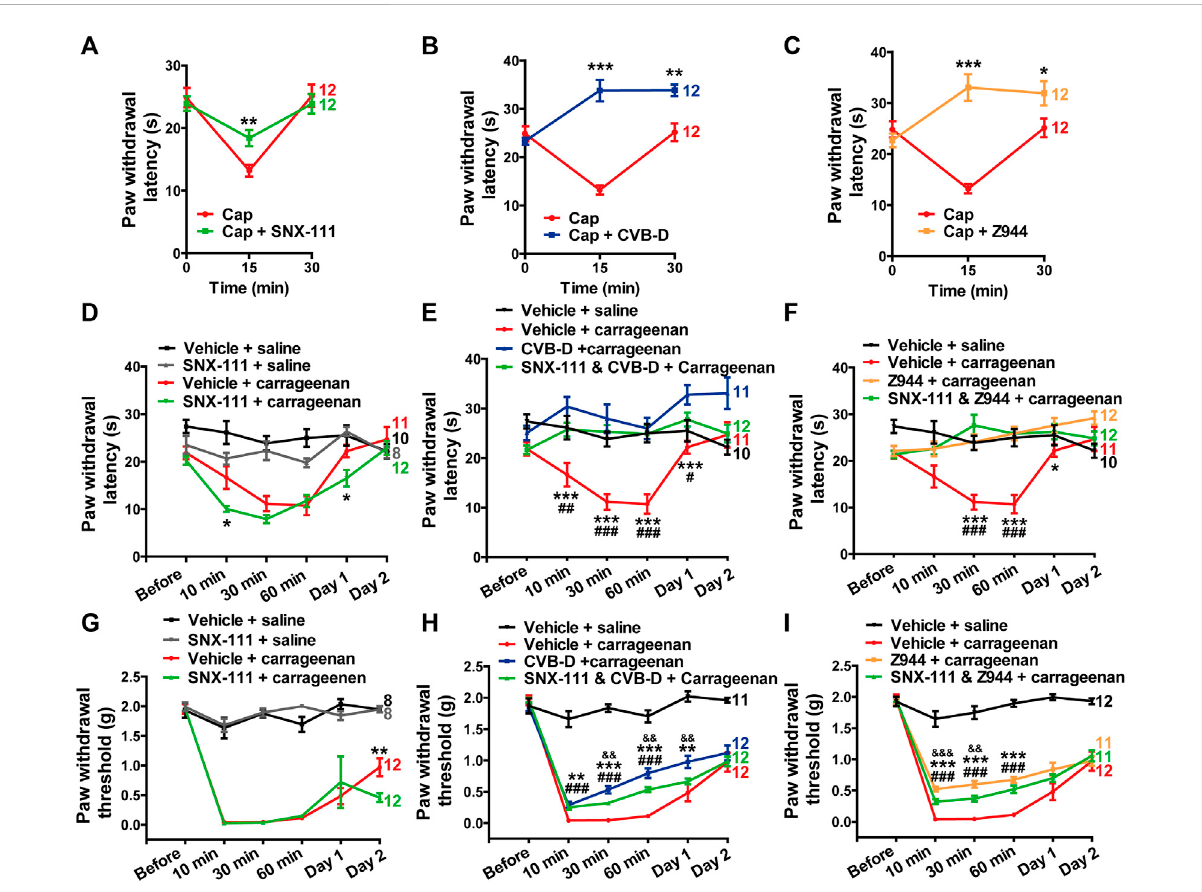
FIGURE 7 MinorroleofCa v 2.2intheanalgesiceffectofCVB-Dinmousemodels. (A – C) EffectofSNX-111(green),CVB-D(blue),orZ944(orange)onCap- induced thermal hypersensitivity. PWL was measured by the hot plate assay at before (0min), and 15 and 30 min after i.pl. injection of Cap. (Red). (D) Effect of SNX-111 on carrageenan-induced thermal hypersensitivity. Same experimental procedures as in Figure 1E, except that SNX-111was intraplantarly injected 30 min prior to carrageenan injection. Statistical analysis was performed between the groups of SNX-111-carrageenan (green)andVehicle-carrageenan(red). (E,F) SynergisticeffectofSNX111andCVB-DorZ944oncarrageenan-inducedthermalhypersensitivity.Same experimental procedures as in D, except that SNX-111 and CVB-D or Z944 were intraplantarly injected together 30 min prior to carrageenan injection. Statistical signi fi cance between the groups of CVB-D-carrageenan (blue) or Z944-carrageenan (orange) and Vehicle-carrageenan (red) wasmarked byasterisks, and that between thegroupsofCVB-D-SNX-111-carrageenan (green)orZ944-SNX-111-carrageenan (green)and Vehicle- carrageenan (red) was marked by pound signs. (G) Effect of SNX-111 on carrageenan-induced mechanical hypersensitivity. Same experimental proceduresasinFigure1E,exceptthatSNX-111wasintraplantarlyinjected30 minpriortocarrageenaninjection.Statisticalsigni fi cancebetweenthe groups of SNX-111-carrageenan (green) and Vehicle-carrageenan (red) was marked by asterisks. (H) Synergistic effect of SNX111 and CVB-D on carrageenan-induced mechanical hypersensitivity. Same experimental procedures as in Figure 7G, except that SNX-111 and CVB-D were intraplantarly injected together 30 min prior to carrageenan injection. Statistical signi fi cance between the groups of CVB-D-carrageenan (blue) and Vehicle-carrageenan (red) was marked by asterisks, that between the groups of CVB-D-SNX-111-carrageenan (green) and Vehicle-carrageenan (red) was marked by pound signs, and that between the groups of CVB-D-SNX-111-Carrageenan (green) and CVB-D-Carrageenan (blue) was marked by ampersand. (I) Synergistic effect of SNX111 and Z944 on carrageenan-induced mechanical hypersensitivity. Same experimental procedures as in H. Statistical signi fi cance between the groups of Z944-carrageenan (orange) and Vehicle-carrageenan (red) was marked by asterisks, that between the groups of Z944-SNX-111-carrageenan (green) and Vehicle-carrageenan (red) was marked by pound signs, and that between the groups of Z944-SNX-111-carrageenan (green) and Z944-carrageenan (orange) were marked by ampersand. Data information: The number ineach graph indicated thenumber of mice used in each experiment. Statistical signi fi cance was evaluated using two-tailed t -test (for two- group comparisons)or one-way analysis of variance (ANOVA) followedby Tukey ’ s and LSD test (for multi-group comparisons), with * p < 0.05, ** p < 0.01,*** p < 0.001, # p < 0.05, ## p < 0.01, ### p < 0.001, p < 0.05, p < 0.01,and p < 0.001.Theexactt,F,and p -valuesareindicatedinAppendixTableS1. All the data are presented as mean ±